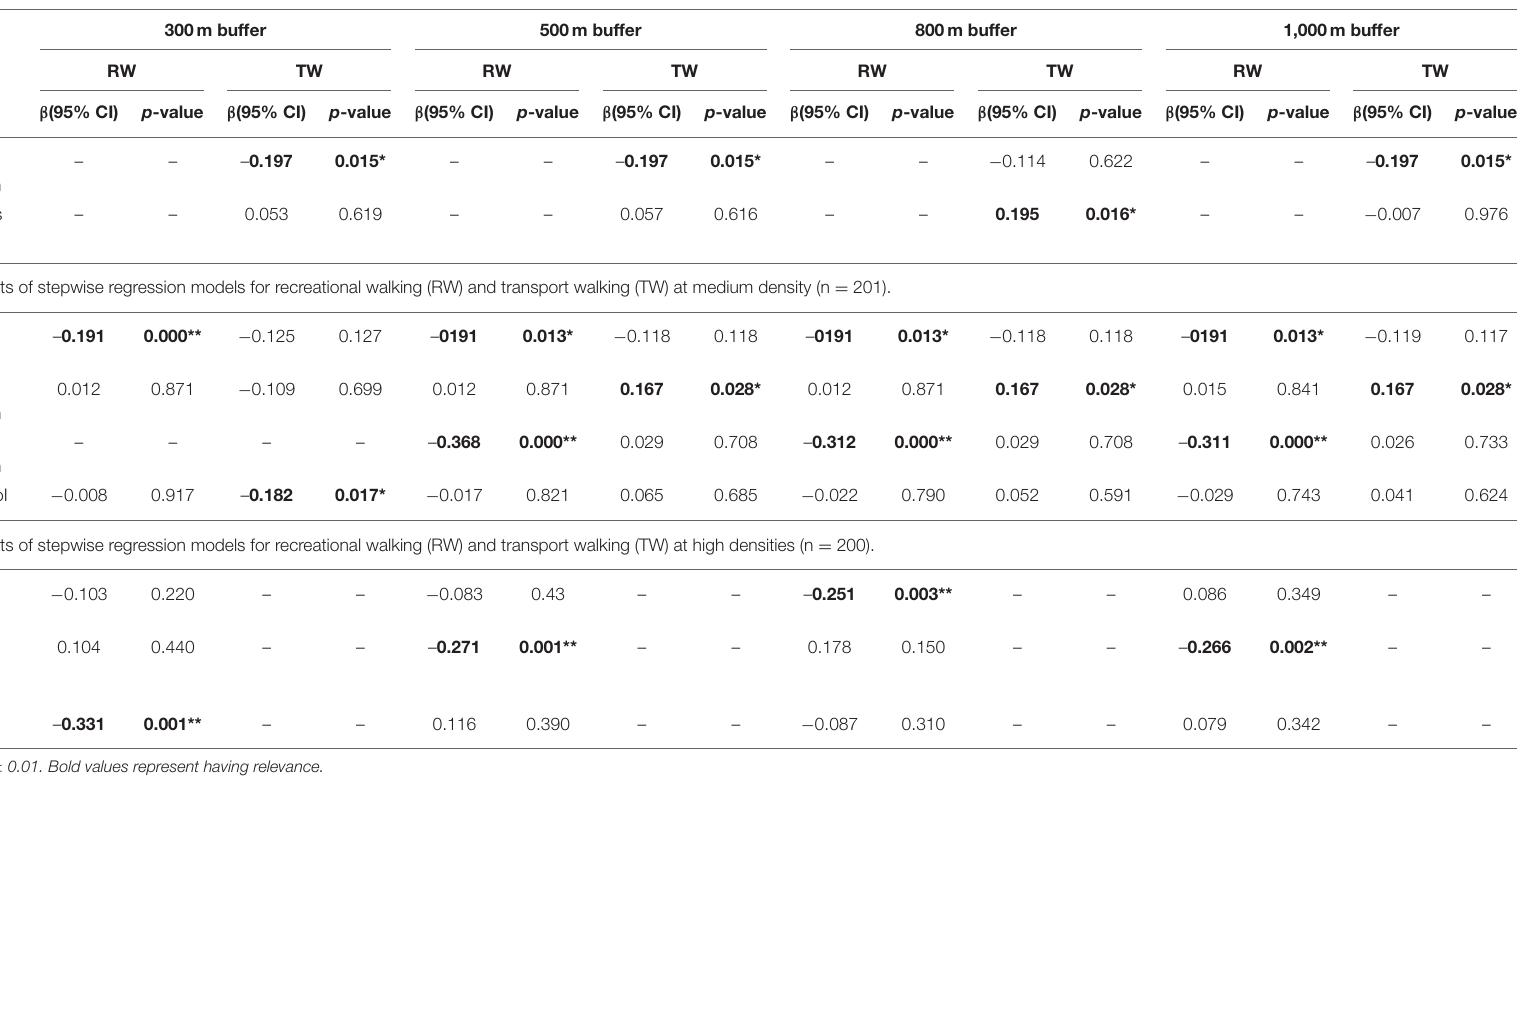
TABLE 5 | Statistical results of stepwise regression models for recreational walking (RW) and transport walking (TW) at low densities ( n =